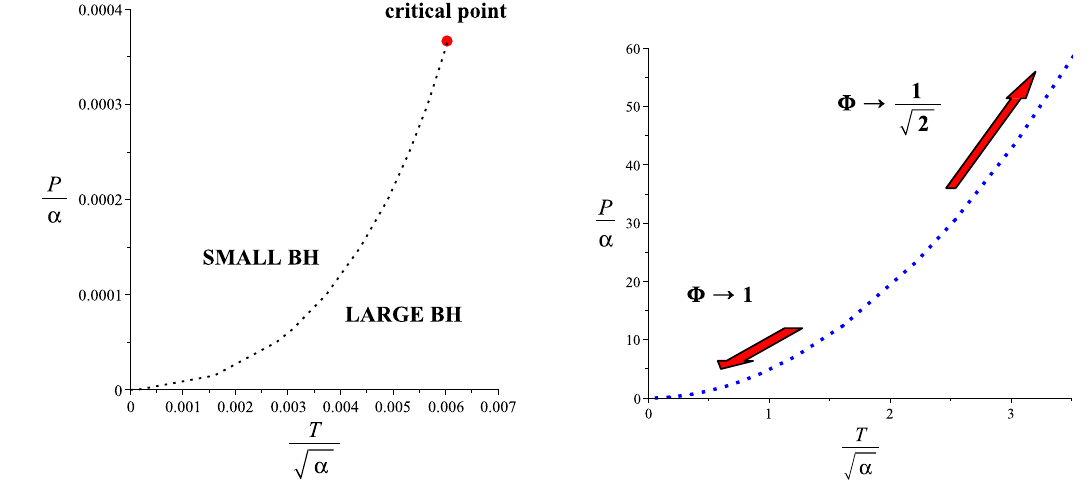
Figure 15 . Left hand side: the dotted line is the coexistence line, (cid:12)nishing at the critical point (the red point), in the grand canonical ensemble for a (cid:12)xed (cid:8) = 0 : 85. Right hand side: trajectory of the critical points with respect to (cid:8). In the limit (cid:8) = 1, the critical point goes to (0 ; 0). In the p limit (cid:8) = 1 = 2, the critical point corresponds to large values of (cid:22) P and (cid:22) T .